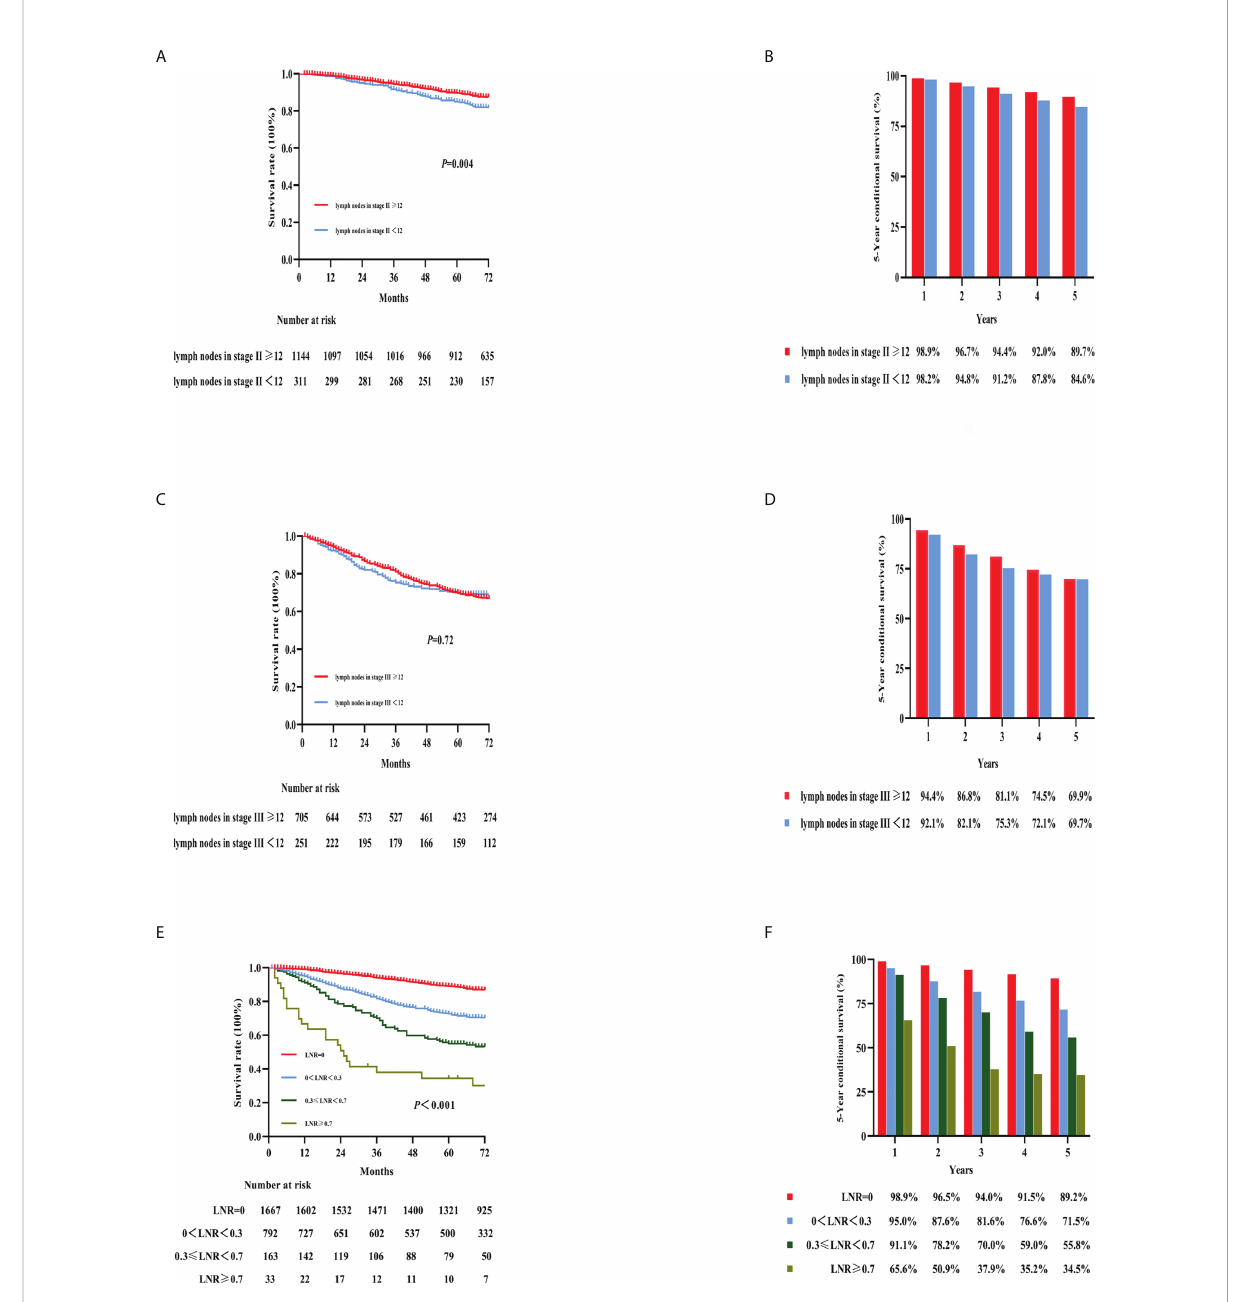
FIGURE 5 Kaplan – Meier curves for the survival analysis according to the number of examined lymph nodes. The fi gures show OS in stage II colon cancer patients (A) , stage III colon cancer patients (C) , LNRs (E) , and the 5-year OS rates of the three categories [ (B, D, F) , respectively]. OS, overall survival; LNR, lymph node